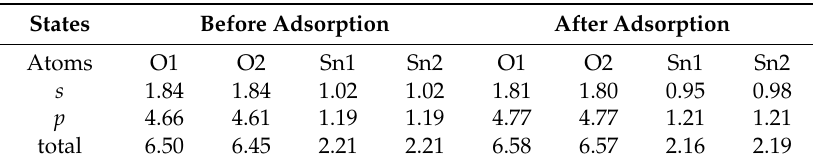
Table 8. Electron density distributions of the pertinent atoms before and after the adsorption of oleate ions on the SnO 2 (110) surface.